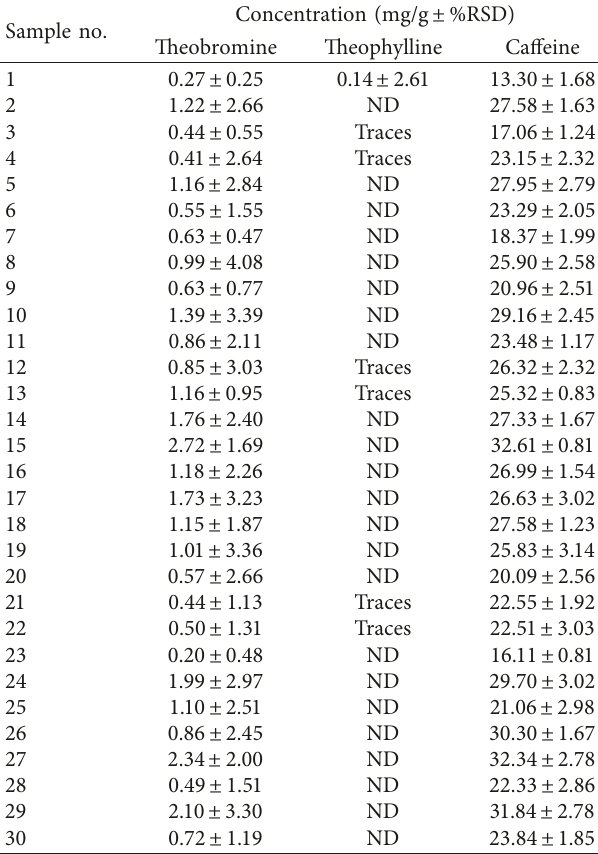
Table 1: The average content of theobromine, theophylline, and caffeine (mg/g ± %RSD) ( n � 5) in commercial tea samples. Sample